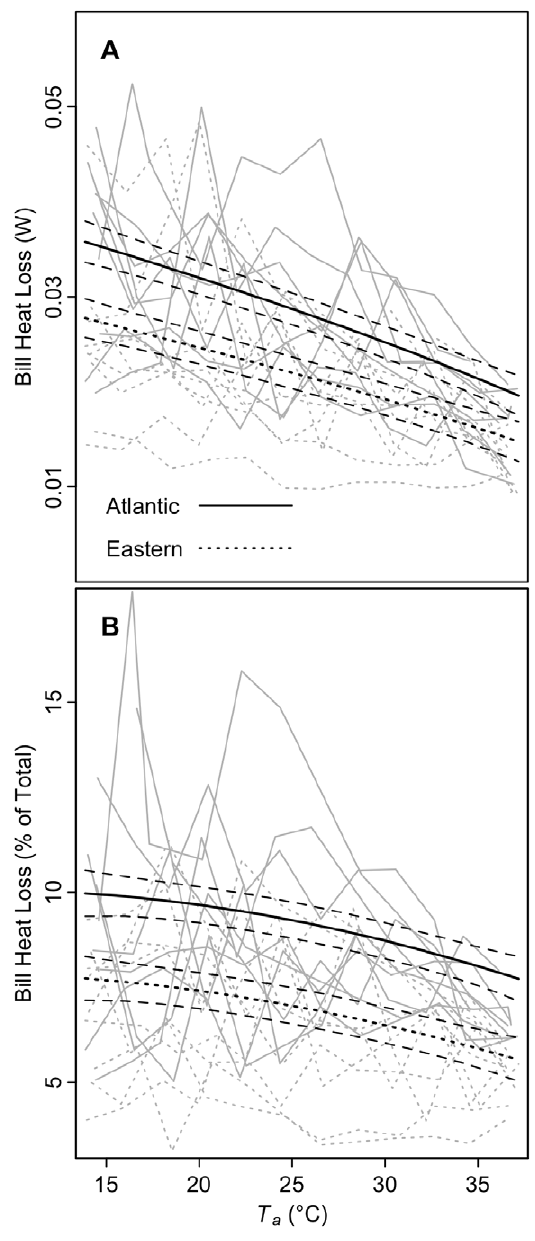
Figure 4. Surface temperatures ( T surface ) of the bill, legs (tarsi), and body of both subspecies of song sparrow vs. ambient temperature ( T a ). Black lines=model averaged predictions of linear mixed models 6 unconditional standard errors. Body and leg surface temperatures did not differ between subspecies (see text). For bill, only the Atlantic subspecies is shown. Gray dashed line indicates T a = T surface